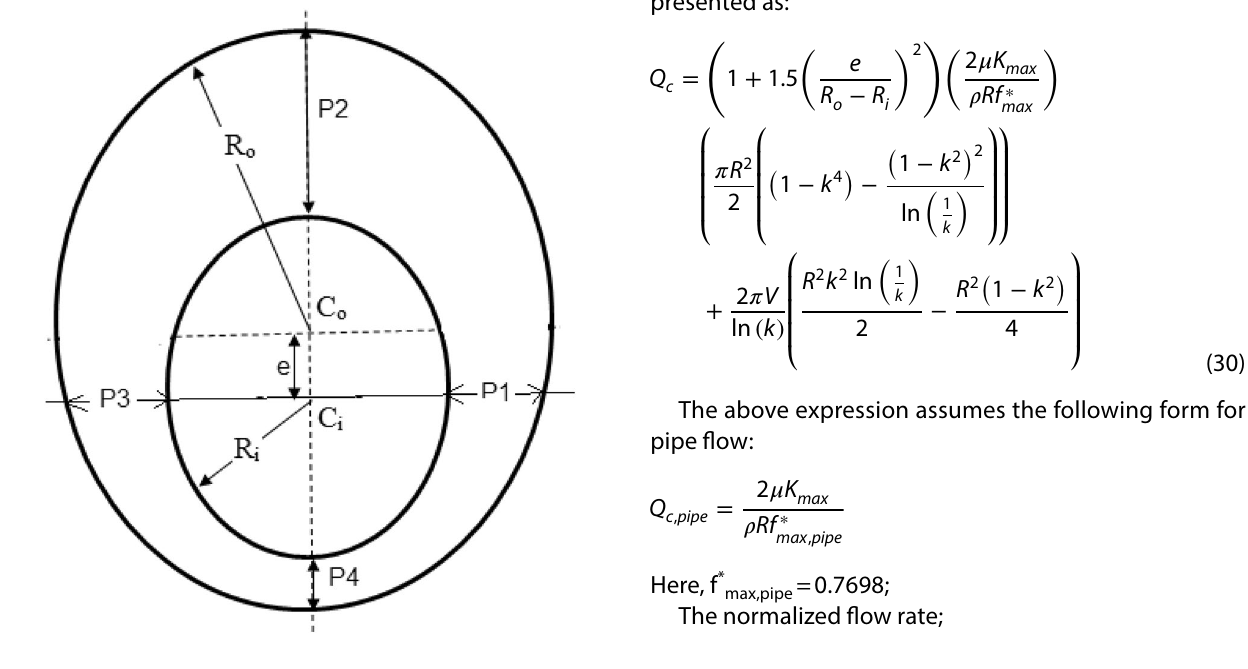
Fig. 2 Azimuthal location of planes P1–P4 in the eccentric annulus